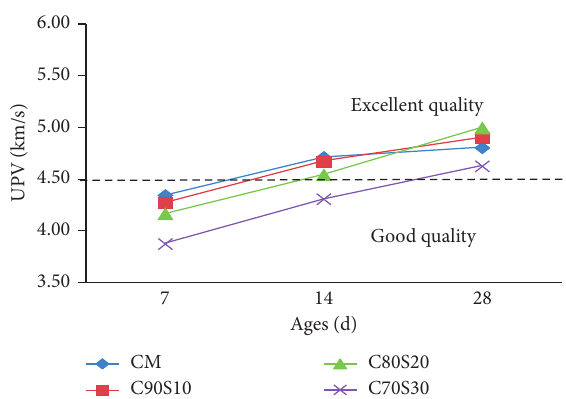
Figure 9: Ultrasonic pulse velocity of concrete mixes.